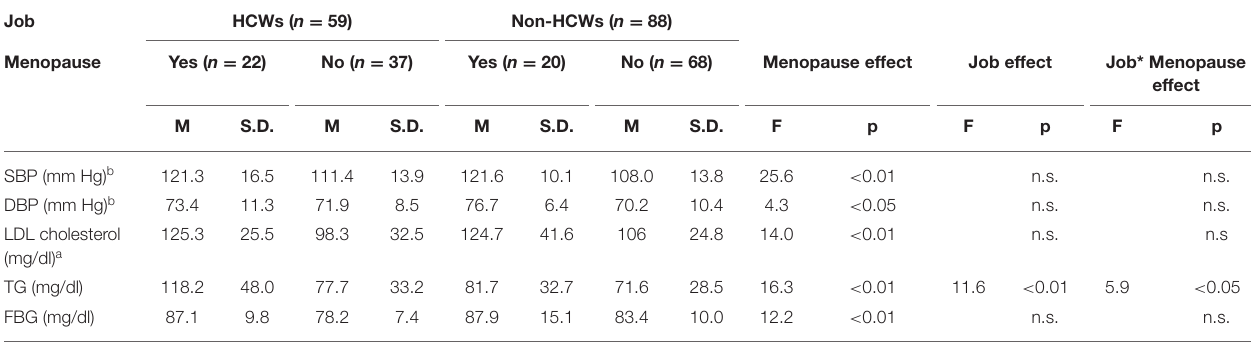
TABLE 5 | UNIANOVA for the analysis of variance in fluid biomarkers between the two groups (HCWs and non-HCWs), further subdivided according to menopausal status, and evaluation of the single or combined effects of job and menopause as confounders. Job HCWs ( n = 59) Non-HCWs ( n = 88)